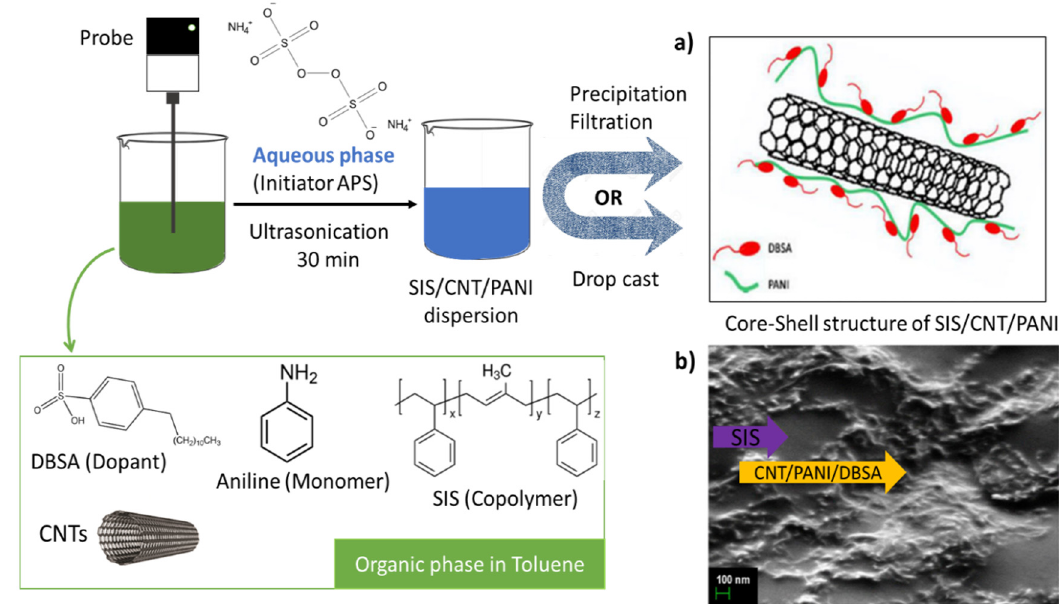
Figure 9. Fabrication via in situ inverse emulsion polymerization of the styrene=isoprene-styrene (SIS)/CNT/PANI elastomeric nanocomposite film by precipitation-filtration or drop-casting and ( a ) schematic structure of the resulting composites and ( b ) HRSEM images (Reprinted from Brook, I.; Mechrez, G.; Suckeveriene, R.Y.; Tchoudakov, R.; Lupo, S.; Narkis, M. The Structure and Electro-Mechanical Properties of Novel Hybrid CNT / PANI Nanocomposites. Polym. Compos. 2014 , 35 , 788–794 [29]; and from Brook, I.; Mechrez, G.; Suckeveriene, R.Y.; Tchoudakov, R.; Lupo, S.; Narkis, M. Electrically Conductive Hybrid Elastomeric Nanocomposites. Composites 2013 , 161 , 1–3 [30], with permission (2020) from